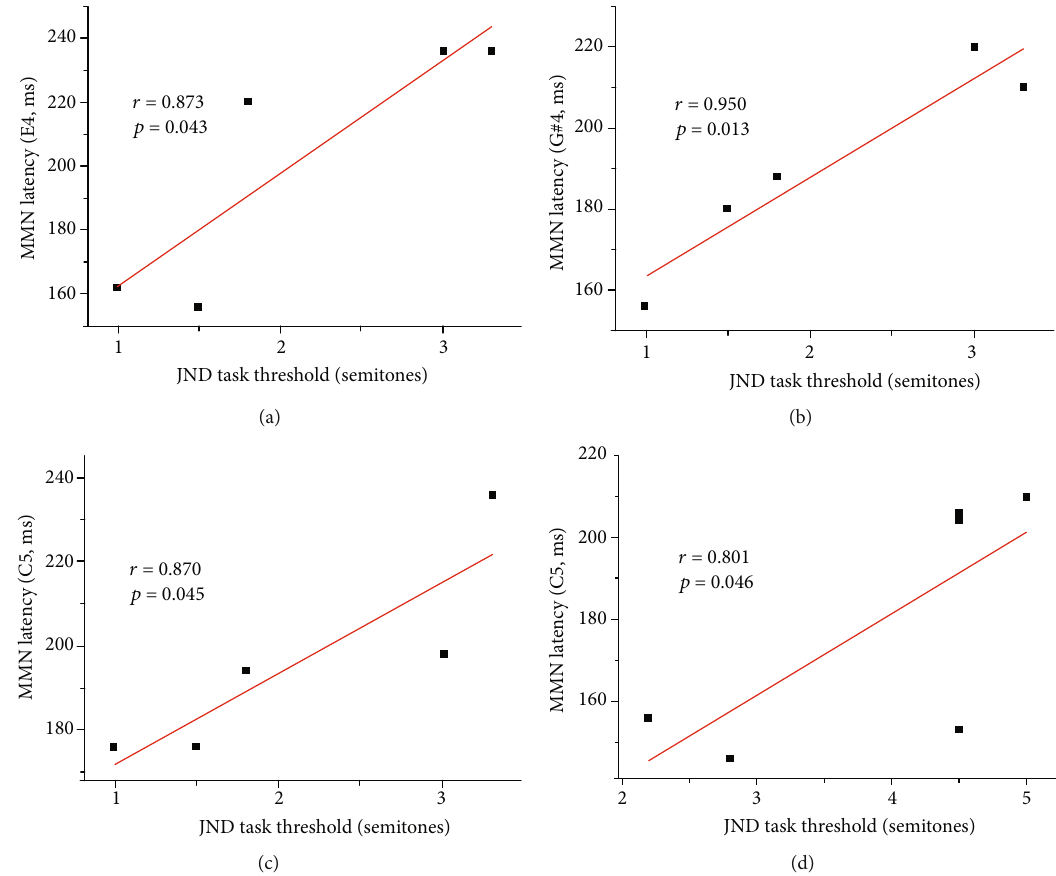
Figure 4: Correlations between JND task thresholds and MMN latency by pitch deviation in CI users with good (a – c) and poor (d) performance. Table 5: Correlations between pitch discrimination thresholds and MMN amplitude and latency by pitch change in CI users with good and poor performance. Signi fi cant correlations ( p < 0 : 05 ) are presented in bold. JND PDD MMN Pitch changes r p r p Amplitude ( μ V) Cochlear implants (good performers)